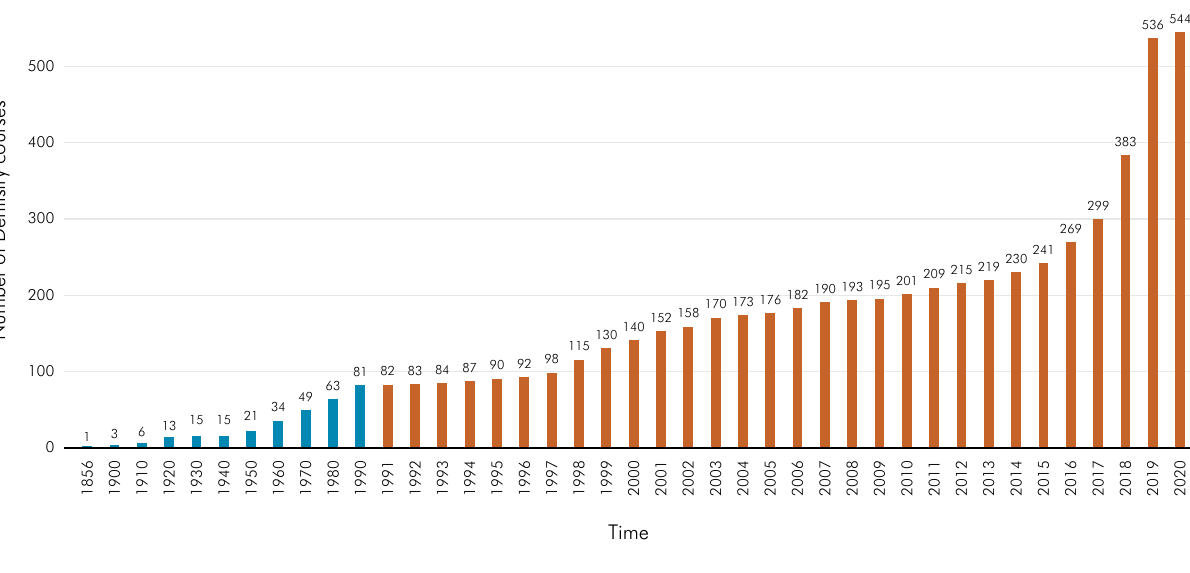
Figure 1. Expansion of the number of Dentistry courses in Brazil from 1900 (n = 3) to 2020 (n = 544) by decades (blue) and by year (orange), obtained from e-MEC 2 and CES.